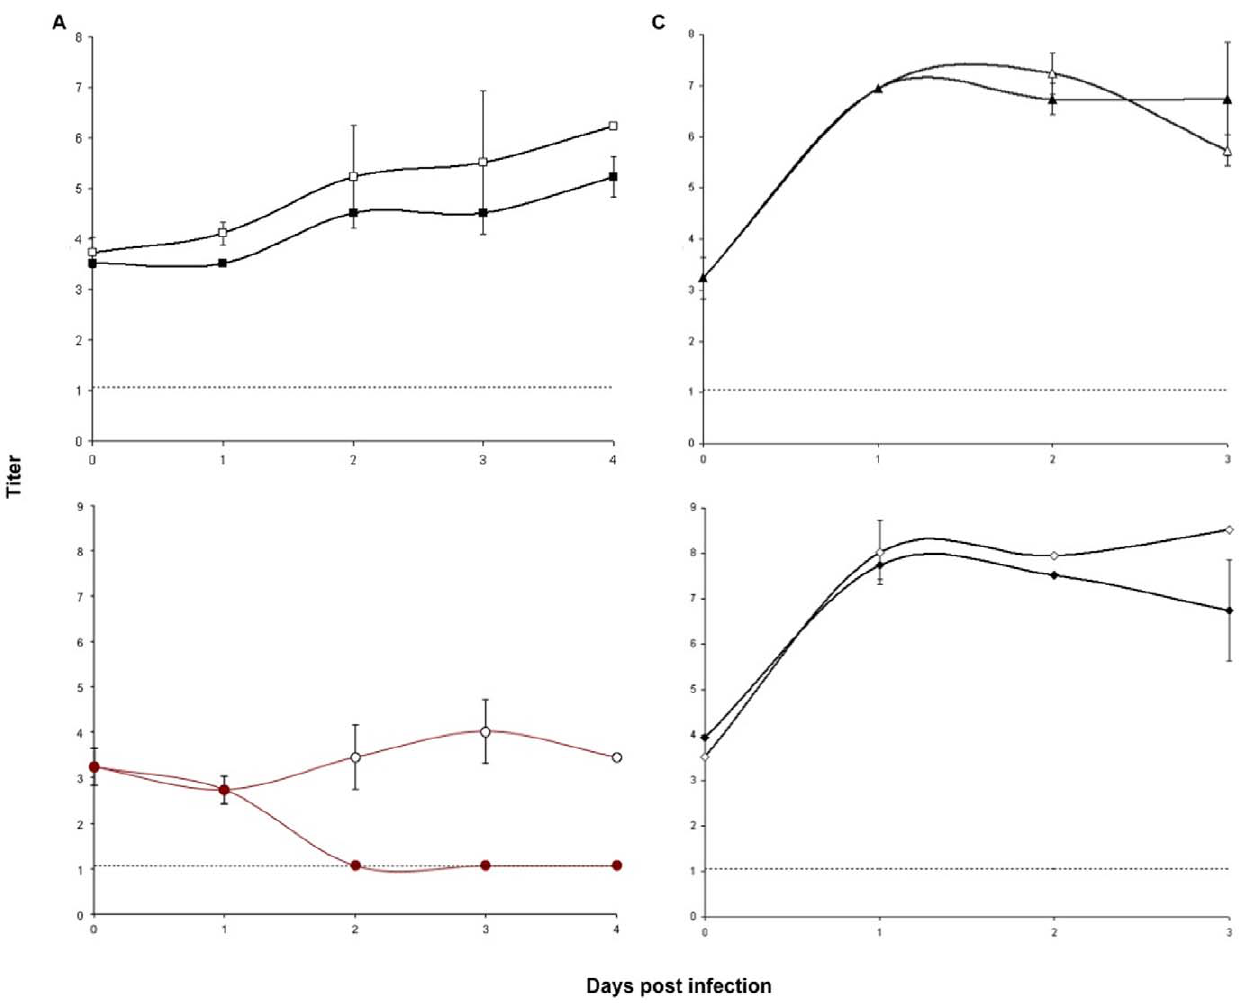
Figure 5. Superinfection of YFV Asibi GFP infected Vero and C 7 10 cells with either YFV 17D Cherry or CHIKV 5 9 Cherry. A) YFV 17D- Cherry growth kinetics on naı¨ve ( % ) and YFV Asibi GFP infected ( & ) Vero monolayers. B) YFV 17D Cherry growth kinetics on naı¨ve ( # ) and YFV Asibi N ) C 7 10 monolayers. C) CHIKV 5 9 Cherry growth kinetics on naı¨ve ( D ) and YFV Asibi GFP infected ( m ) Vero monolayers. D) CHIKV 5 9 GFP infected ( Cherry growth kinetics on naı¨ve ( e ) and YFV Asibi GFP infected ( ¤ ) C 7 10 monolayers. Titers expressed as log 10 TCID 50 /mL.